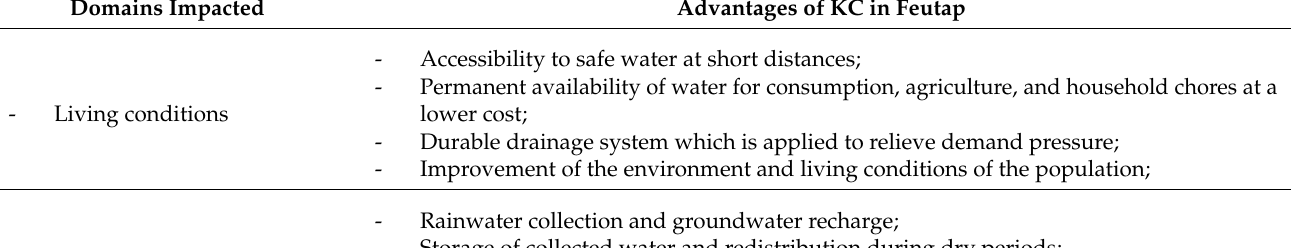
Table 2. Benefits of the application of the Kilimanjaro Concept (KC) in Feutap .